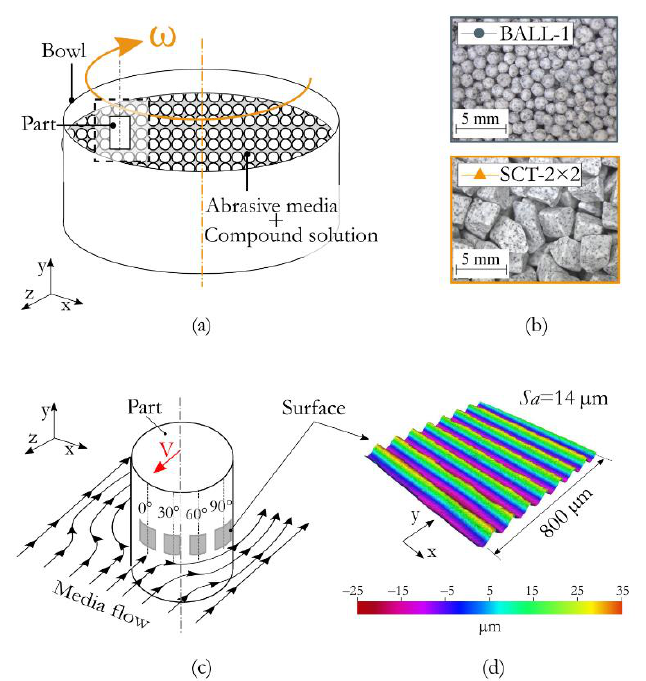
Figure 1. ( a ) Experimental setup, ( b ) abrasive media, ( c ) media flow around the sample and ( d ) surface topography before drag finishing. surface topography before drag